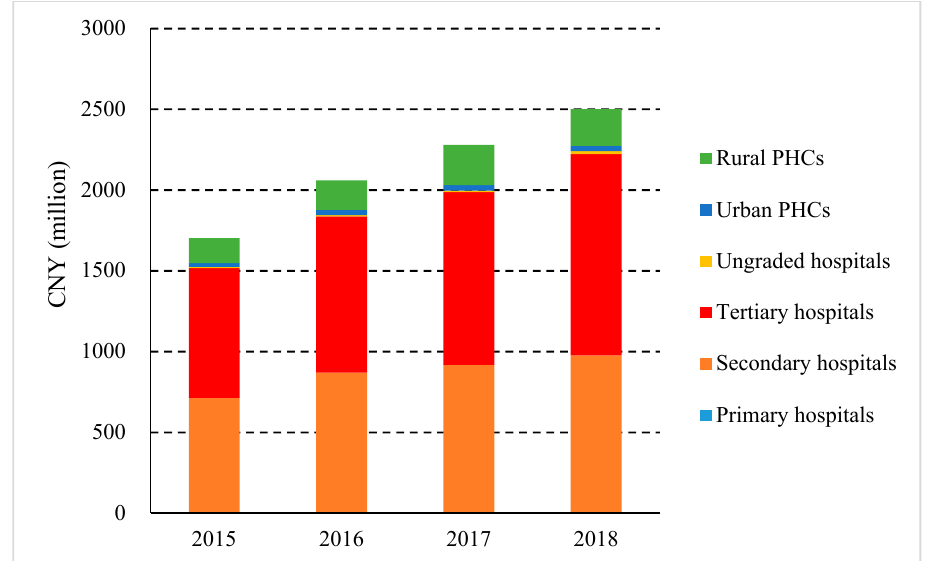
Figure 4. Consumption and expenditure of antibiotics in different healthcare institutions in Shaanxi Province, western China, 2015–2018. (DDDs, defined daily doses; CNY, Chinese Yuan).